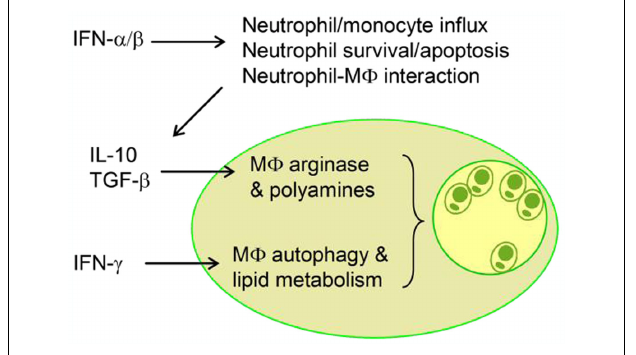
FIGURE 2 |A schematic diagram illustrates the interplays between innate immune cells and the regulatory roles of key cytokines during infection with Leishmania amazonensis . Modulation of intracellular pathways by host and/or parasite factors can lead to enlarged vacuoles and enhanced parasite